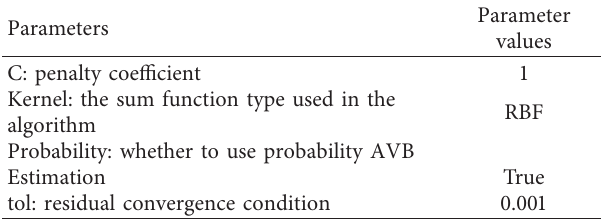
Table 2: Support vector machine training parameters.